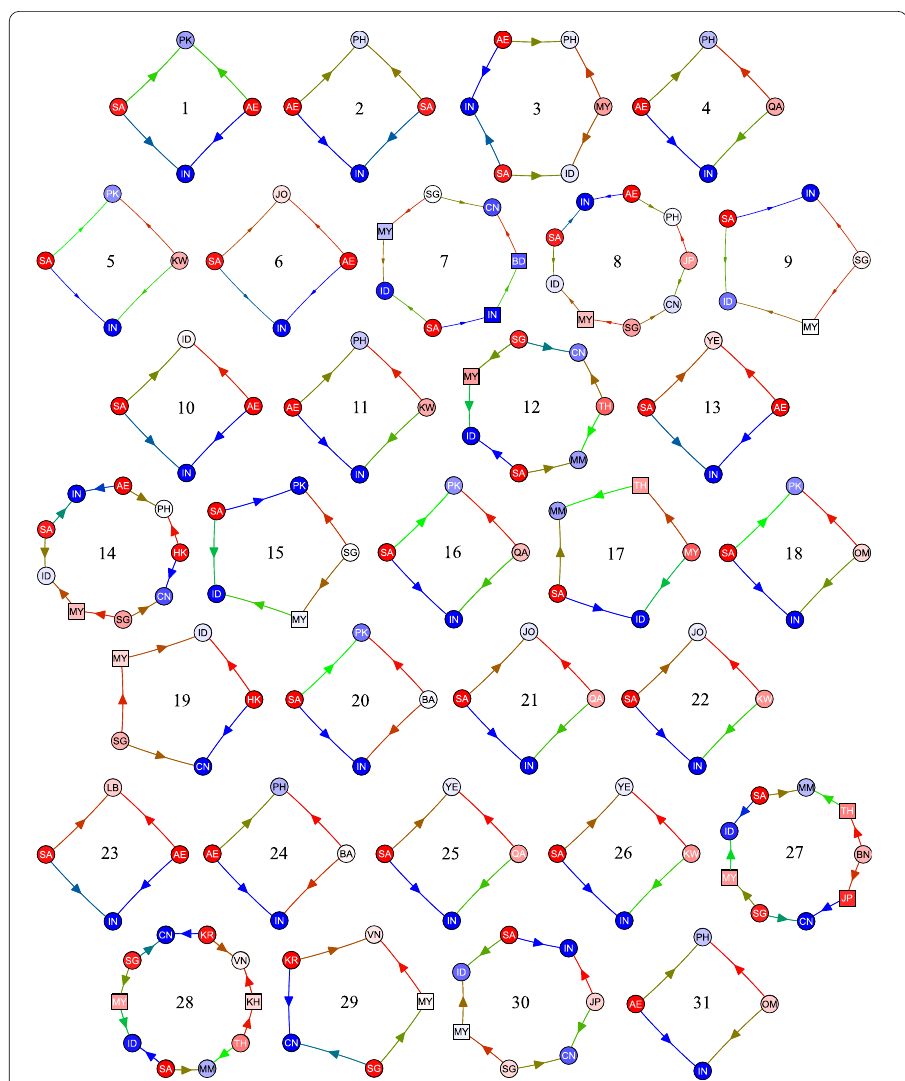
Figure 17 Cyclic flow of remittances in Asia. 1-cycle generators for the 2015 Asian net remittance network